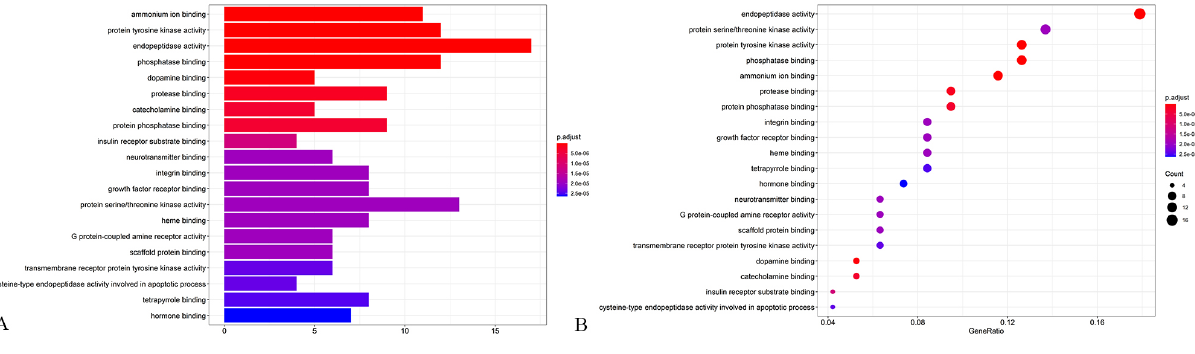
Fig. 3. The diagrams of GO functional-enrichment analysis . (A) The histogram of GO functional-enrichment analysis. The letters on the left of the graph are the names of GO biological functions, and the numbers below are the number of genes enriched on GO. The bar graph represents the biological functions enriched on GO, and p represents the significance of enrichment. The redder the color, the higher the degree of enrichment, and the smaller the corresponding p -value. (B) The bubble diagram of GO functional-enrichment analysis. The principle is the same as the